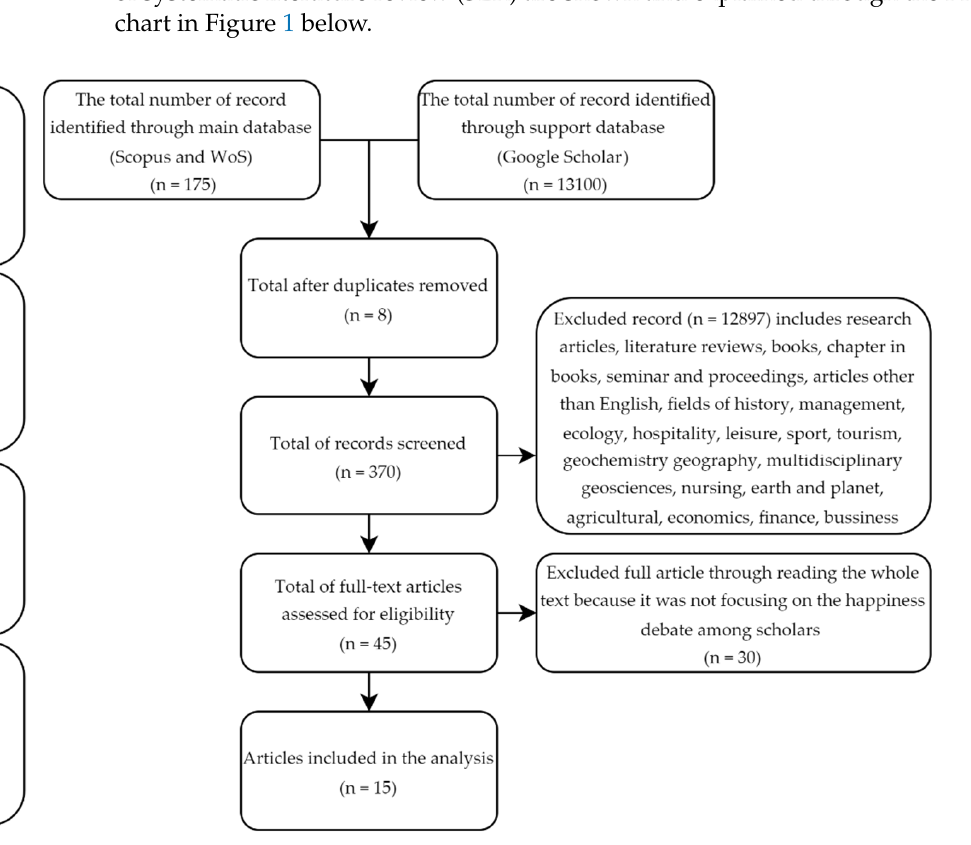
Figure 1. PRISMA Flow Chart. Source: Adapted from Moher et al. [8] and Shafrill et al. [10].